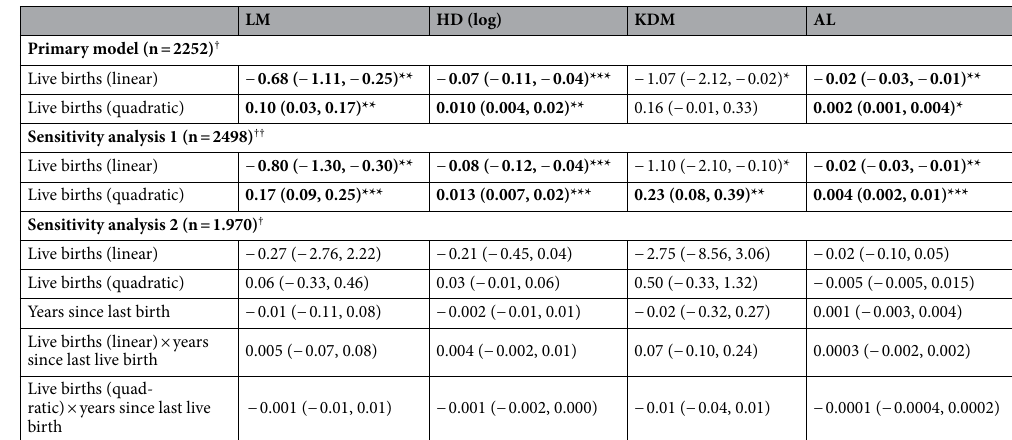
Table 3. Multiple linear regression examining the durable and transient effects of number of live births on biological age acceleration for post-menopausal women only, National Health and Nutrition Examination Survey 1999–2010. Values represent coefficient estimates and 95% confidence intervals. Notes: * p < 0.05, ** p < 0.01, *** p < 0.001; values in bold represent effects significant after multiple comparison correction at α = (0.05/4) = 0.0125. † Models were adjusted for the following variables: chronological age, body mass index, federal income-to-poverty ratio, smoking, education, and self-identified race/ethnicity. †† Model was adjusted for chronological age only.